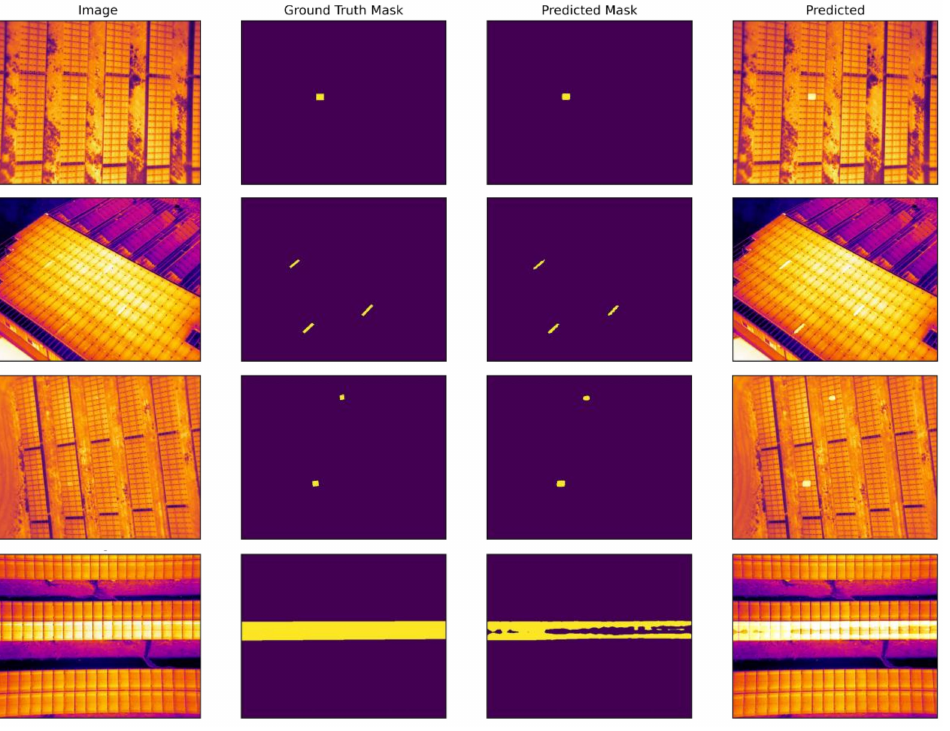
Figure 9. Original, ground-truth mask, model-predicted mask and predicted overlay images of PV plant fault detection experiment using DeepLabV3+ segmentation model.